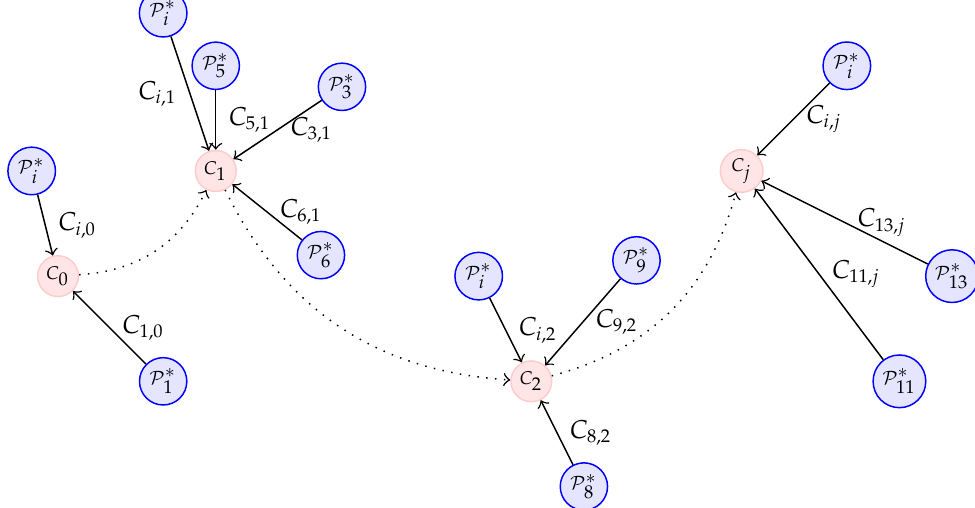
Figure 5. Poses graph for the camera localization problem.